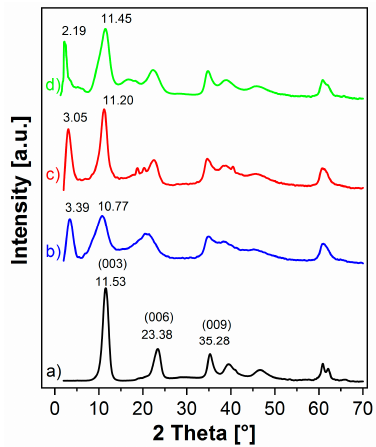
Figure 2. XRD patterns of ( a ) pristine LDH, ( b ) LDH-phosphate, ( c ) LDH-decanoate, and ( d ) LDH-phosphinate.